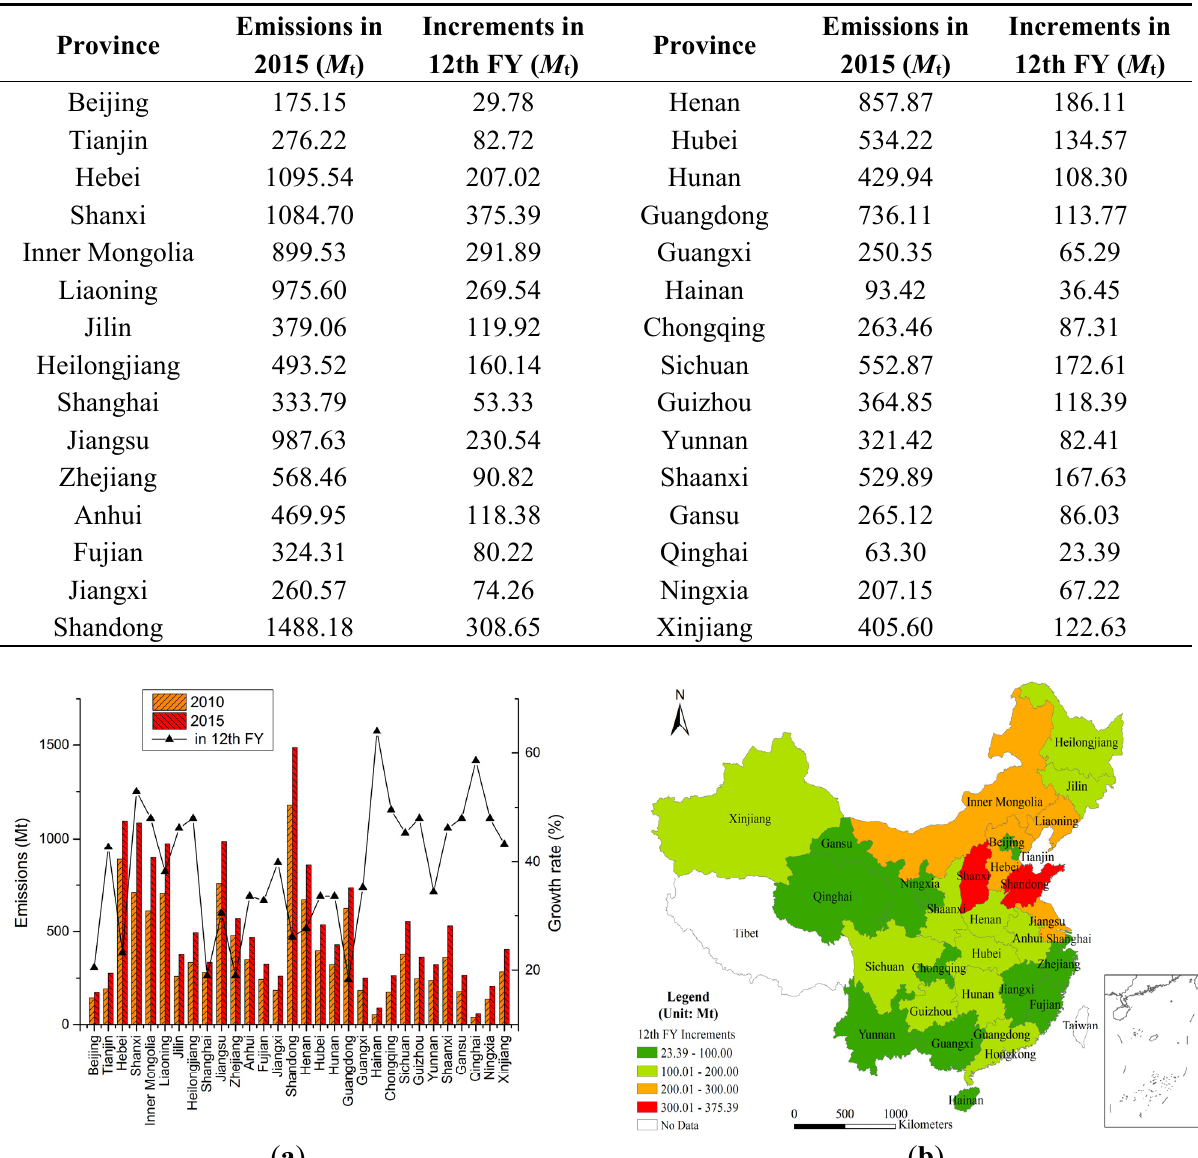
Table 2. Provincial total control and increments of CO 2 emissions.